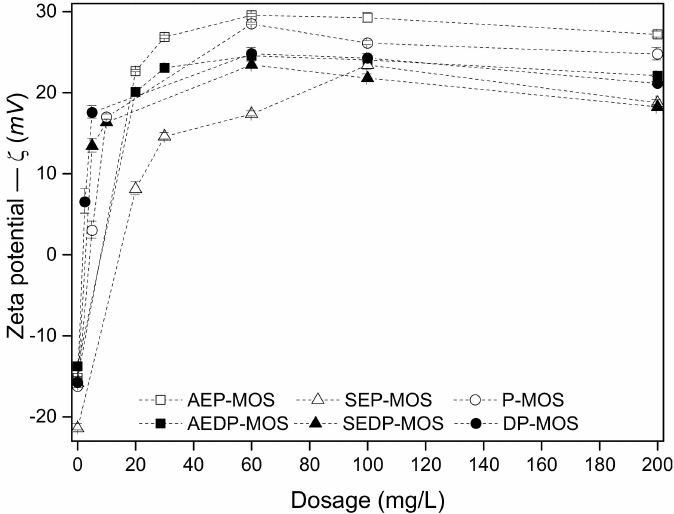
Figure 3. Zeta potential (mV) as a function of Moringa oleifera seed-derived coagulants dosages in jar tests.